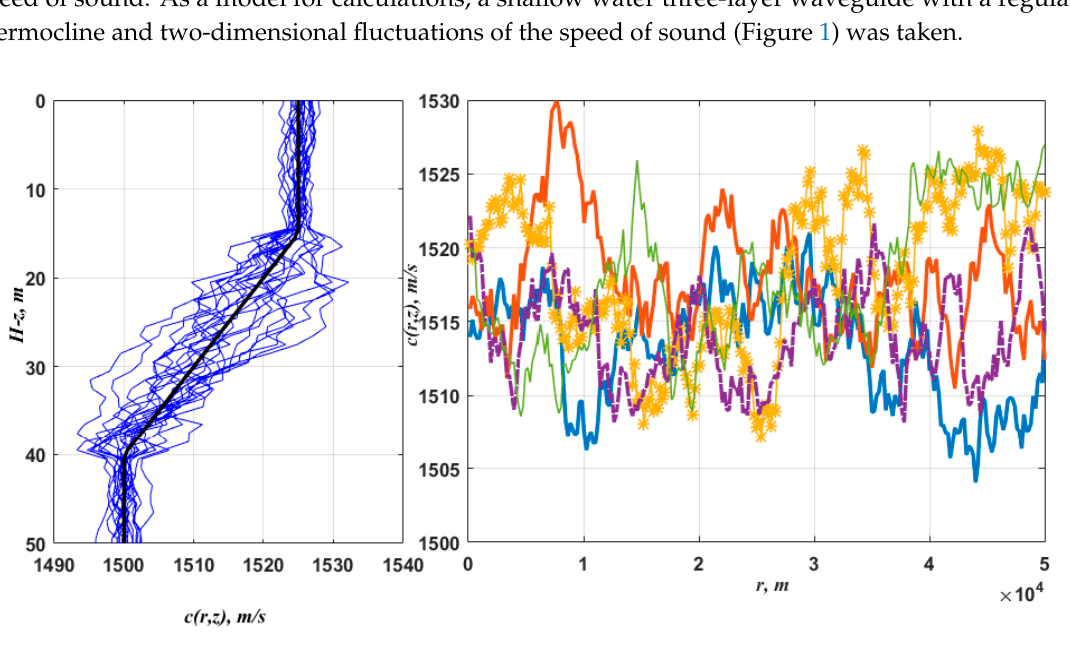
Figure 1. Random shallow water waveguide. The left graph: r = 19900 m, 20 random realizations of a sound speed profile from the ensemble of 1000. The right graph: 5 random realizations of a sound speed profile along the propagation path at the horizon H-z = 25 m.